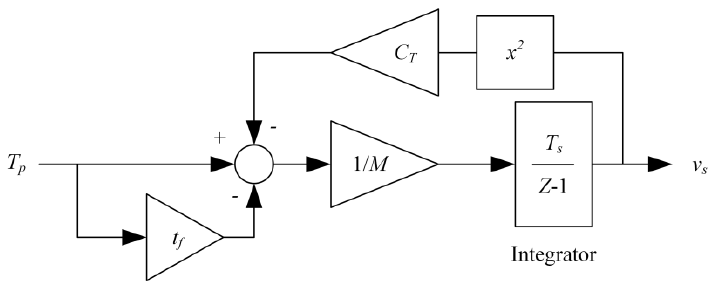
Figure 5. Propulsion system model